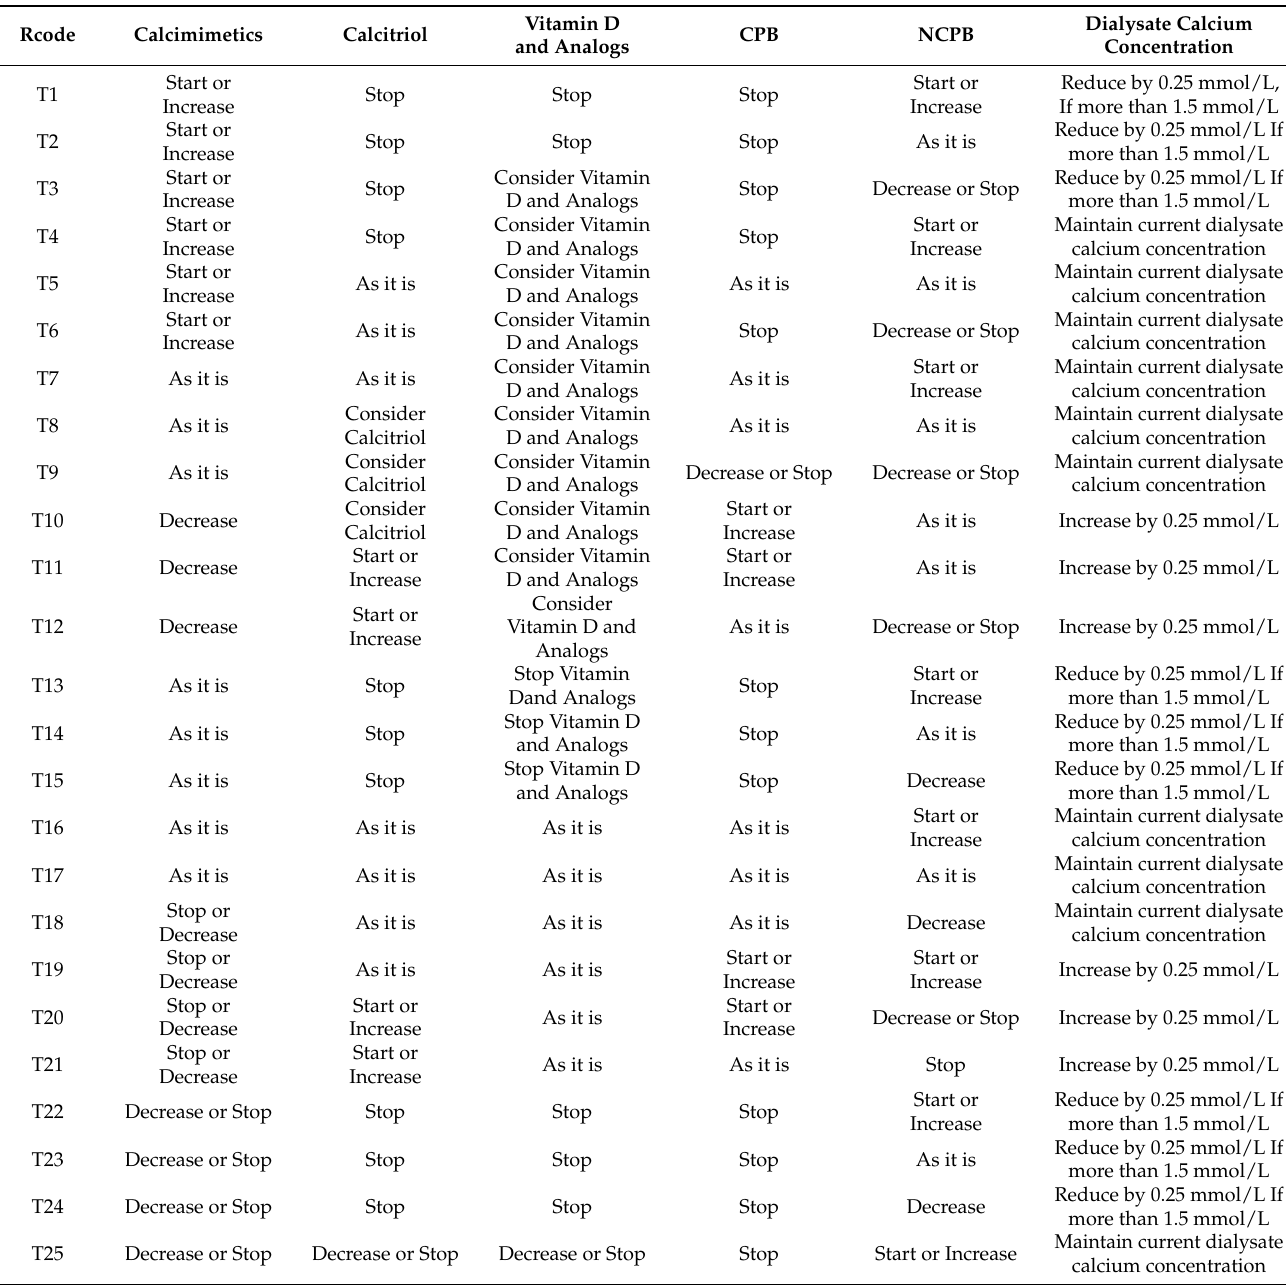
Table A1; Complete list of 33 mutually exclusive partitions (generic recommendations). Table A1. A list of 33 generic